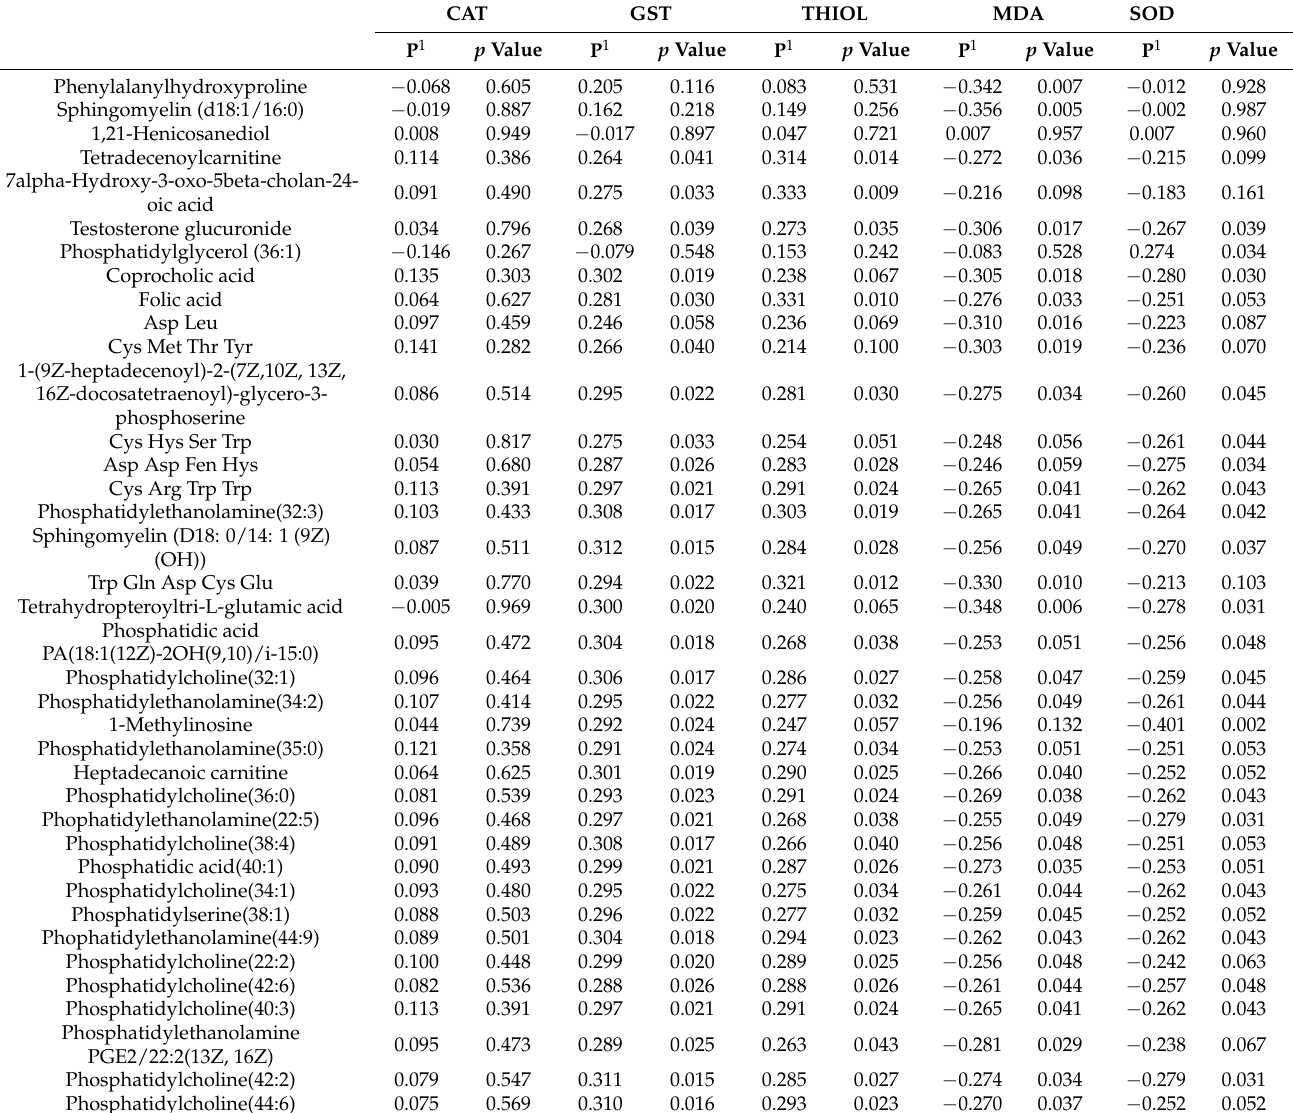
Table 3. Spearman correlation between urinary metabolites and oxidative stress